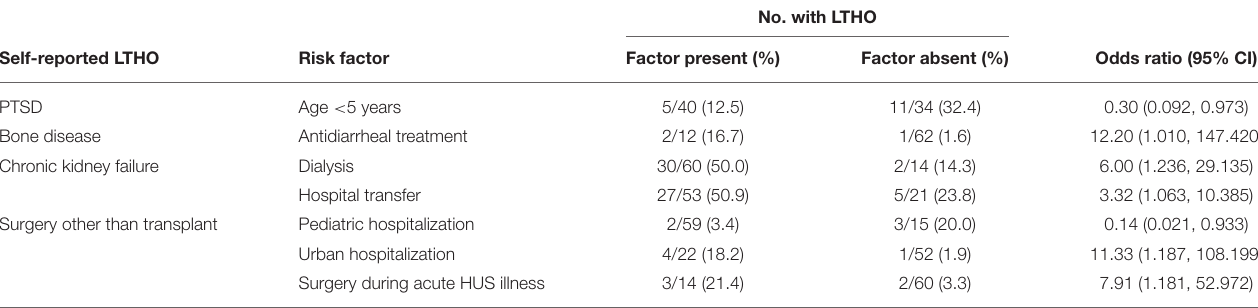
TABLE 5 | Significant univariable logistic regression associations between risk factors and long-term health outcomes following HUS a .